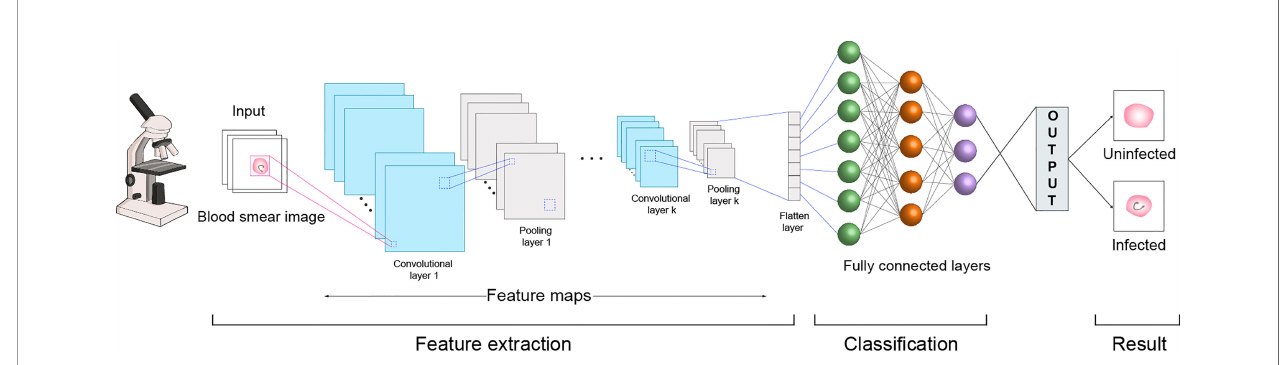
FIGURE 2 | Parasite recognition and detection in blood smear image using CNN approach. A blood smear image for intracellular parasite infection is a typical microscope image, which allows CNN to take in an input microscope image, assign importance (learnable weights and biases) to various aspects and be able to accurately differentiate a parasite-infected red blood cell from a normal red blood cell or discerning different lifecycle stage of a parasite. The feedforward layers of CNN contain the input layer, convolutional layer, pooling layer, fl atten layer, and fully connected layer. A three-dimensional matrix presents the image data contained in the input layer, and the image is reshaped into a single column. To conduct the convolution operation, the layer is used to create several smaller picture windows to deliver data information. Pooling is a down-sampling operation capable of reducing the dimensionality of the feature map. The fl atten layer is used to “ fl atten ” the input, that is, making the multi-dimensional input into one-dimensional data. The fully connected layer is used to identify and classify the object of an image, thereby obtaining output results for probabilistic detection in red blood